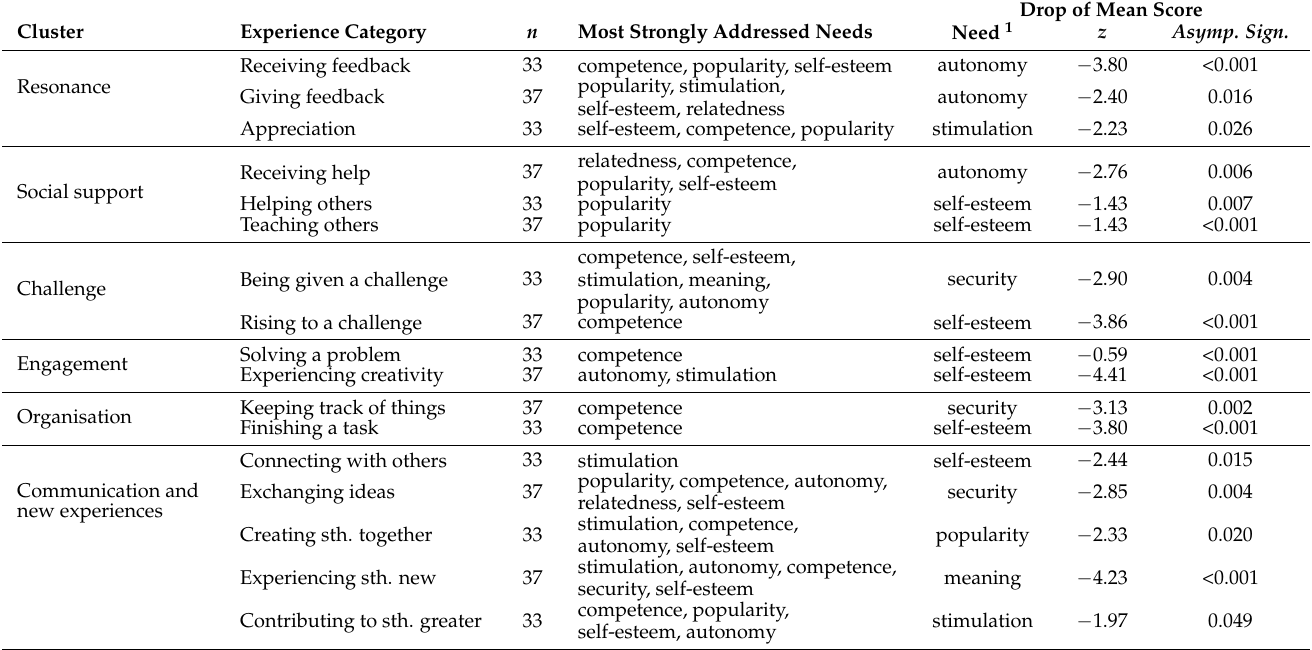
Table 7. Needs that were the most strongly addressed by the experience categories and test statistics of the Wilcoxon tests used to identify the drop in the mean ratings of the needs scales for each experience